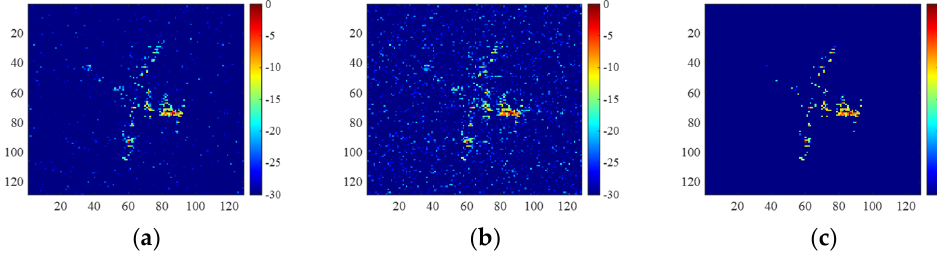
Figure 16. Yak-42 images of the 2D incomplete data obtained by ( a ) 2D-FISTA, ( b ) untrained 2D-ADN, Figure 16. Yak ‐ 42 images of the 2D incomplete data obtained by ( a ) 2D ‐ FISTA, ( b ) untrained 2D ‐